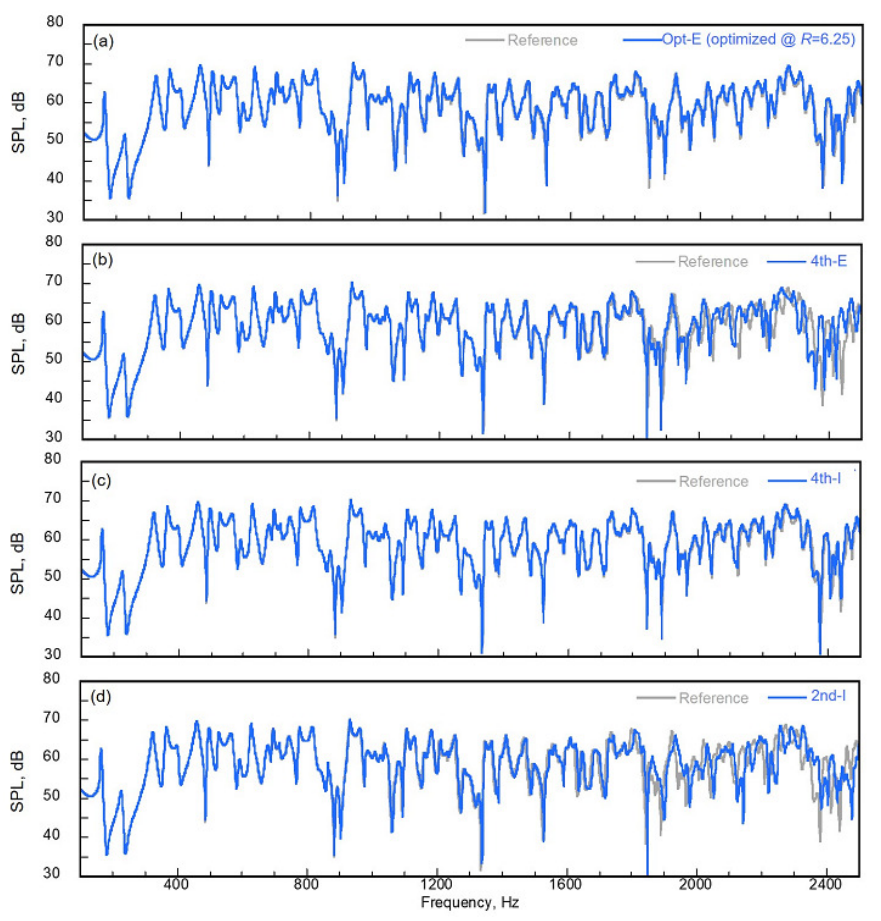
Figure 7. Comparisons of SPL spectra at receiver ( x , y , z ) = (0.6, 0.5, 0.5): ( a ) the reference solution vs. the Opt-E TD-FEM (optimized at R = 6.25), ( b ) the reference solution vs. the 4th-E TD-FEM, ( c ) the